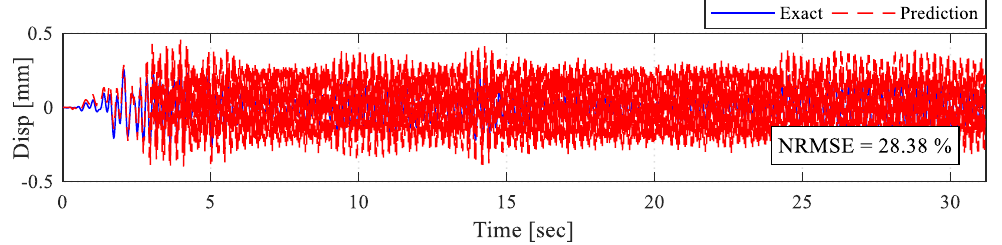
Figure 19. LSTM-predicted brace displacement input from Model 1a RTHS test without specimen but based on actual feedback as compared to the exact analytical solution.